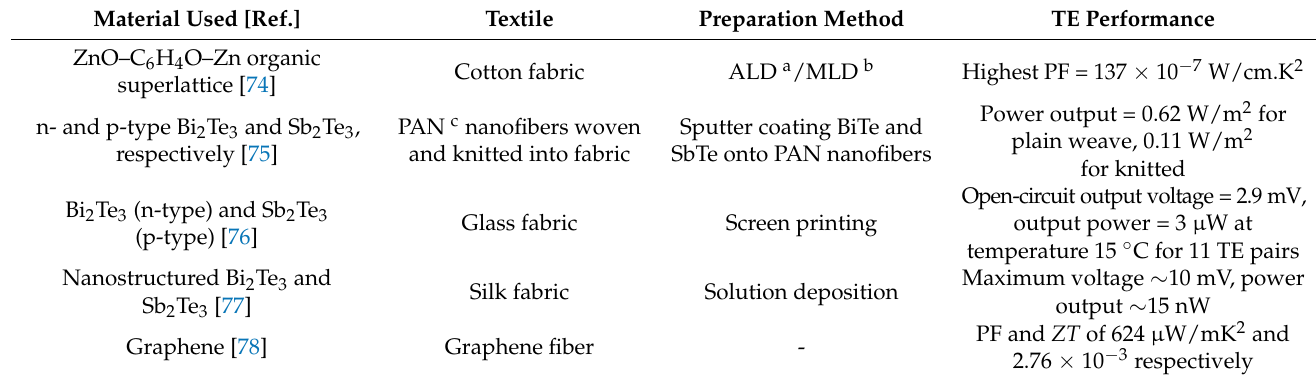
Table 1. Various TE materials used for textile-based TE devices and their performance. Material Used [Ref.]